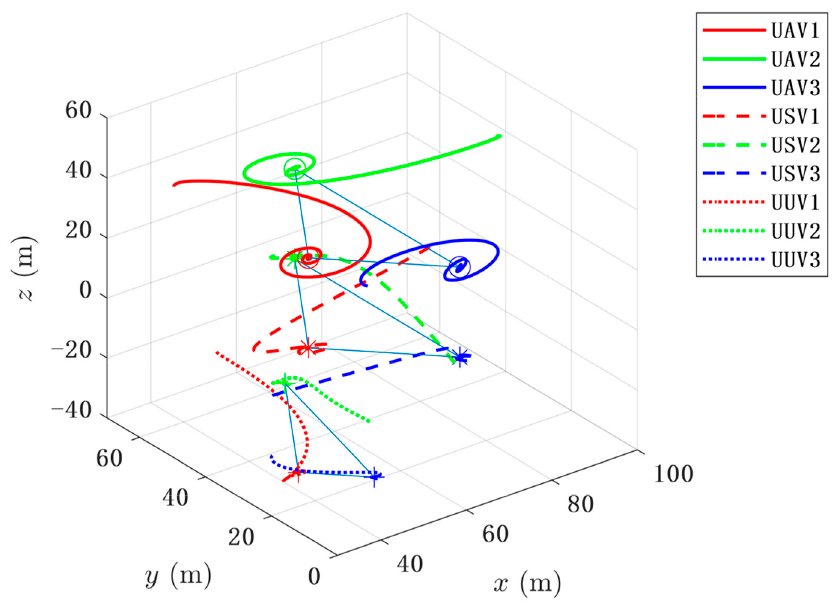
Figure 9. Static formation state with cooperative control and optimal